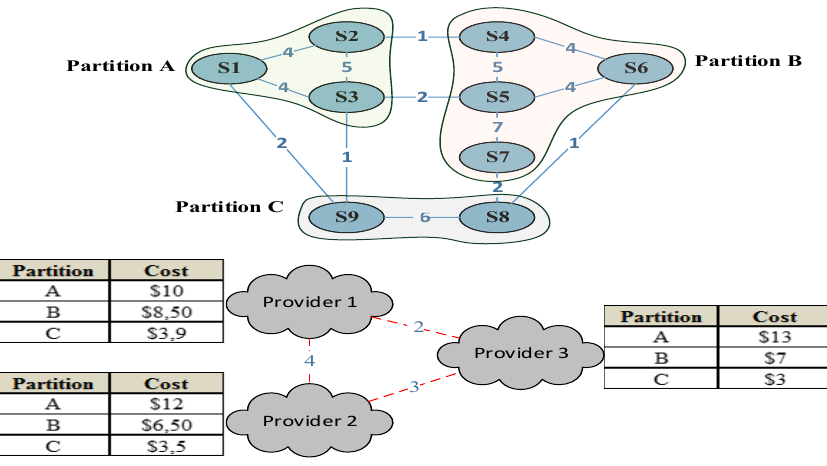
Fig. 7. Cost-Aware Provider Selection